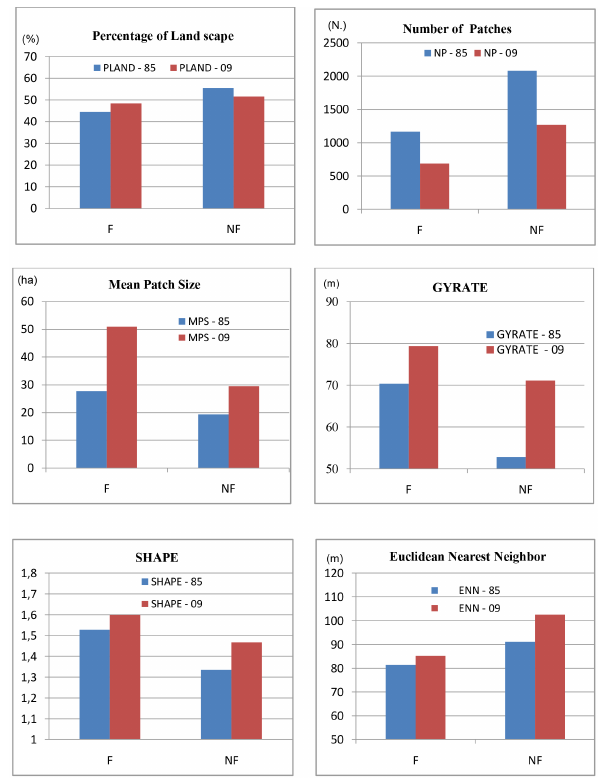
Figure 5. Histograms of the used metrics at class level for the forest/non-forest ecomosaic (1985–2009). For further details